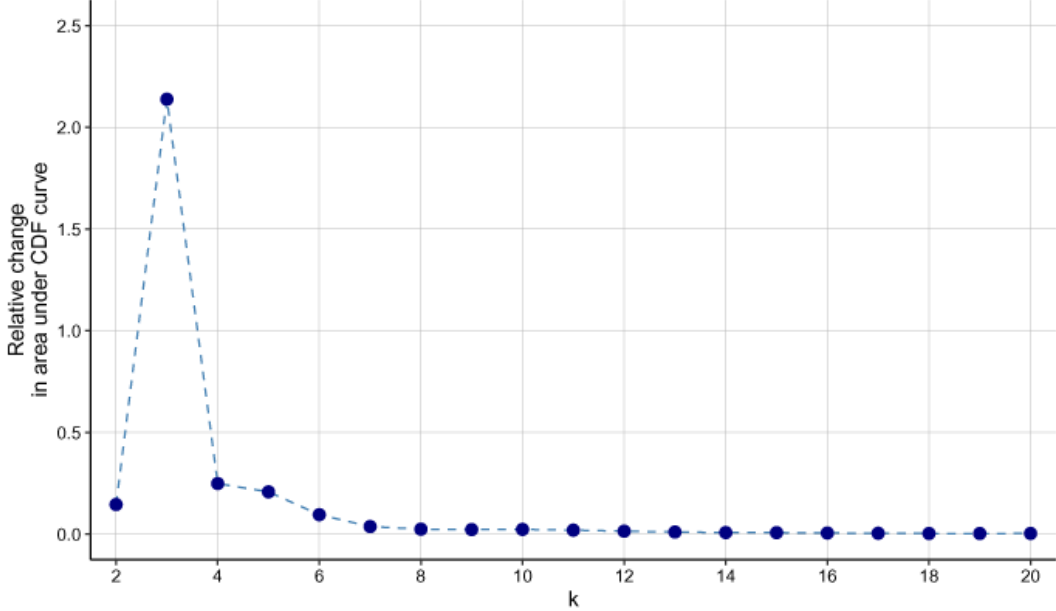
Figure 18. The delta area plot generated in the metaclustering step by the ConsensusClusterPlus function. The delta area score (y-axis) indicates the relative increase in cluster stability obtained when clustering the 100 SOM codes generated by FlowSOM into k groups